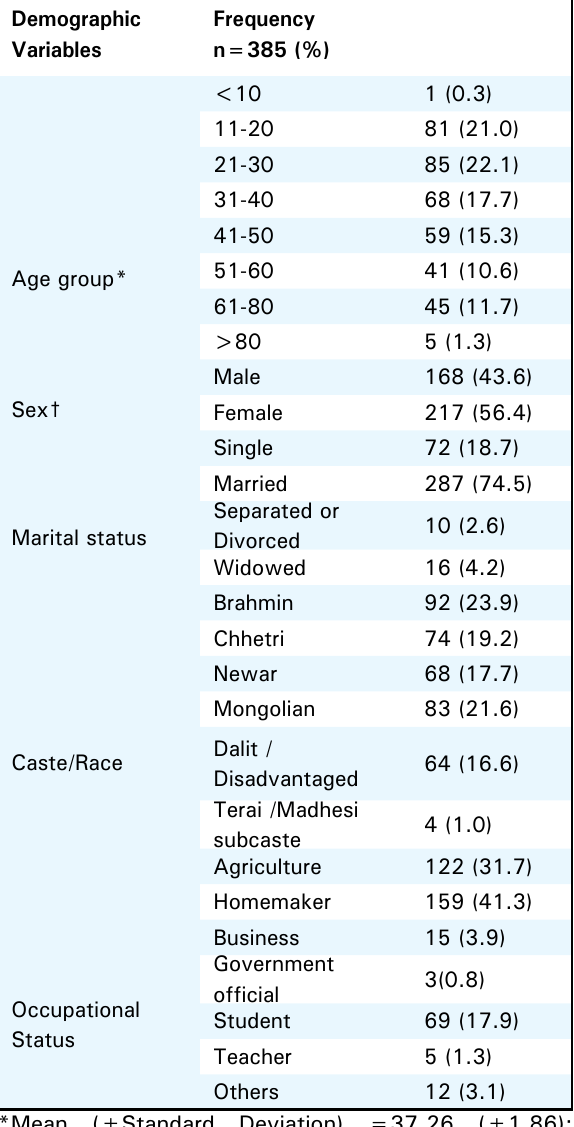
Table 1. Demographic profile of the Patients evaluated from Oct 10 to Sept